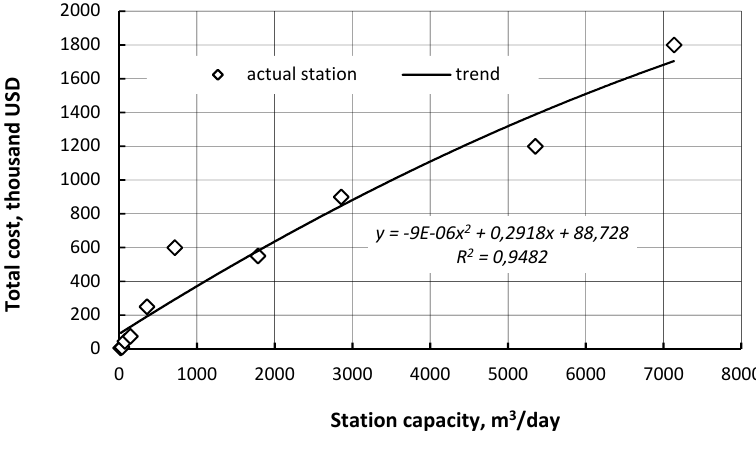
Figure 19. CNG fueling station cost [56].